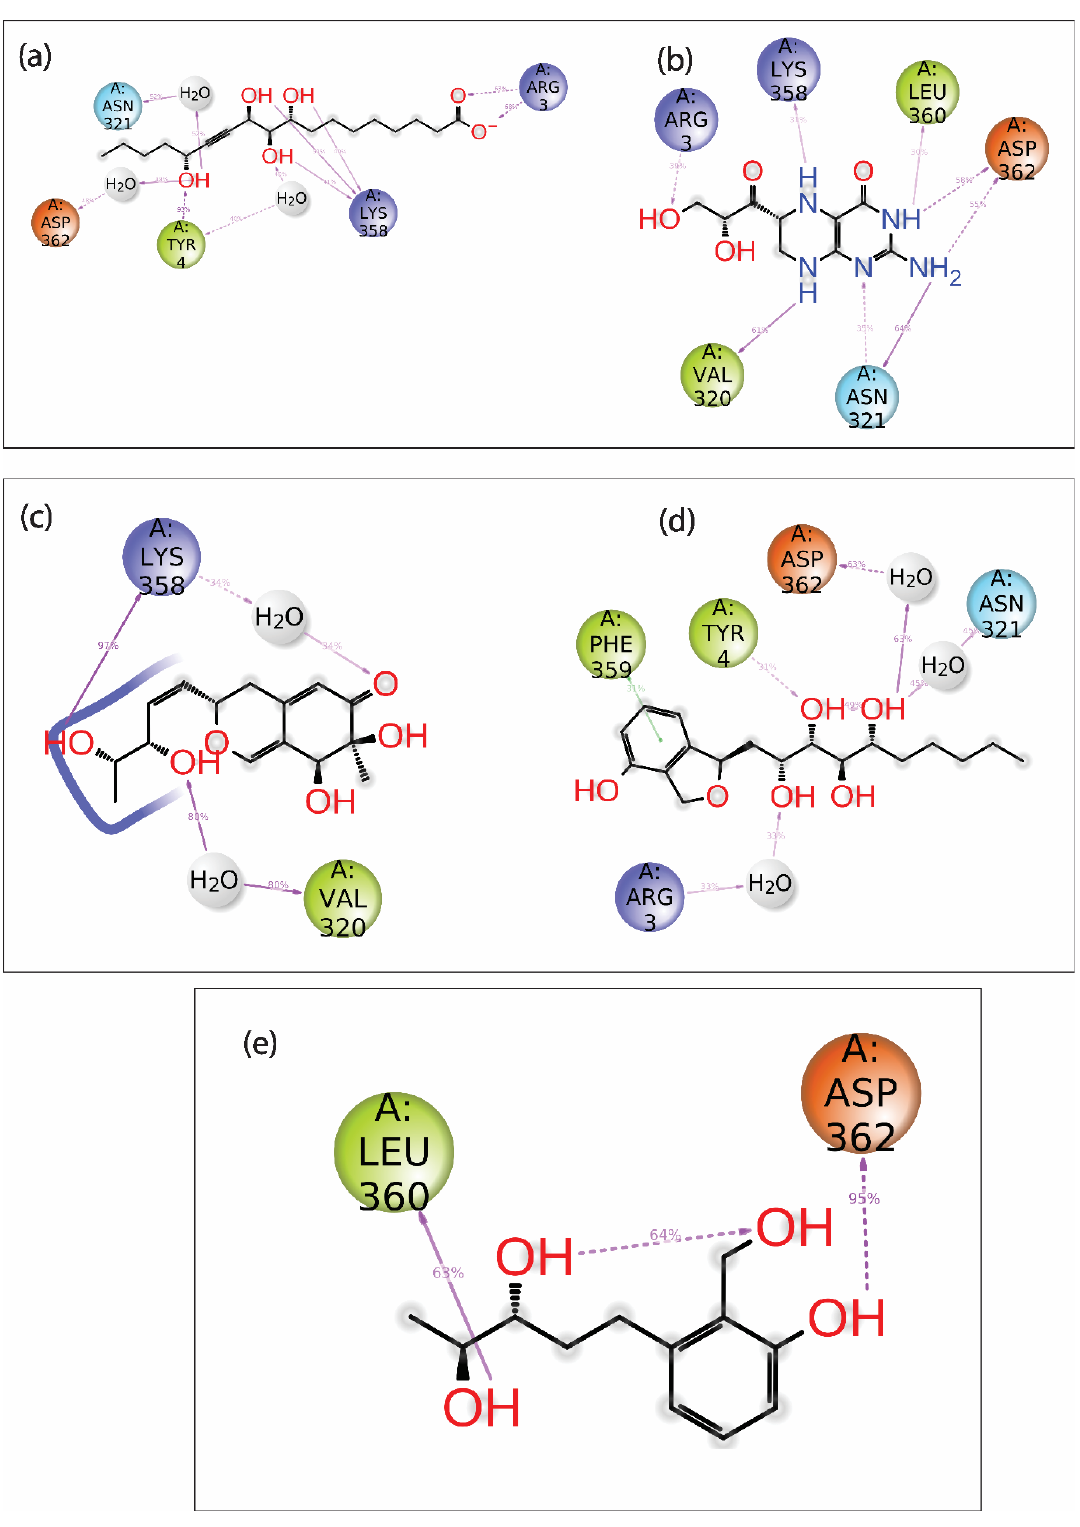
Figure 7. 2D interaction diagram of protein–ligand contact for viral protein with selected natural compounds, i.e., ( a ) Gallicynoic Acid F, ( b ) H2 Erythro-Neopterin, ( c ) Nigcollin C, ( d ) NPA024545, and ( e ) Vaccinol M.